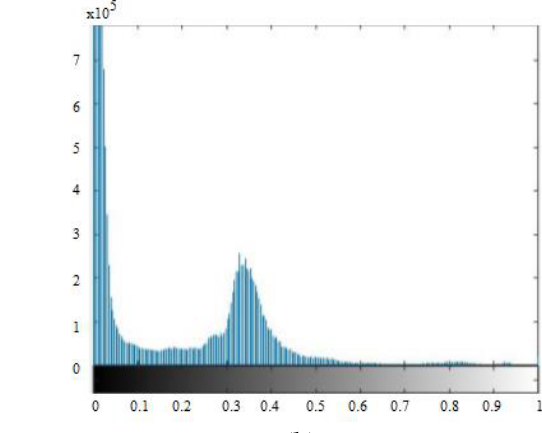
Figure 5. Thresholds on the histogram of a mammographic image in CC view and tissues that make up the image. 3.5. CLAHE: Contrast Limited Adaptive Histogram Equalization Contrast-limited adaptive histogram equalization (CLAHE) [34 – 36] is a technique based on adaptive histogram equalization (AHE), where the histogram of the resulting image is calculated from the histogram of a local window centered on each pixel, which is called the “neighborhood region.” It has been shown that the AHE algorithm can en- hance areas of interest in medical images, although there is an over-enhancement of noise. 3.5.1. Implementation of the Algorithm The CLAHE algorithm consists of four stages: setting the input parameters, pre-pro- cessing, region processing, and interpolation. • The image, the number of regions specified in rows and columns, the number of his- togram bars used to establish the transfer function, and the normalised limit value between 0 and 1 must be established first.